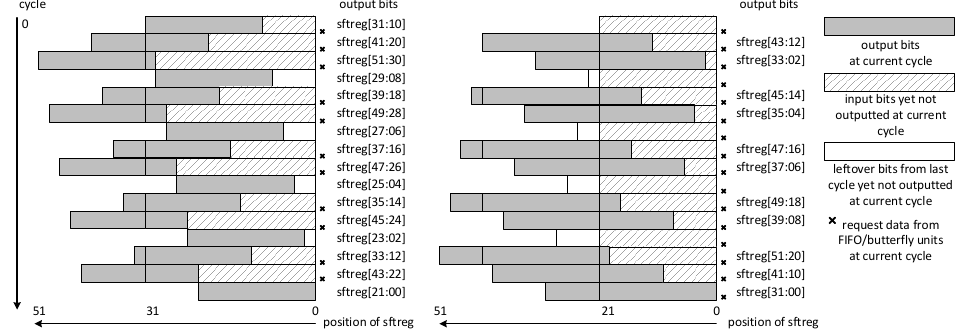
Figure 6: Detailed working flow and content in shift register during Decode( u ) in decryption phase (left) and Encode( u ) in encryption phase (right) with parameter k =